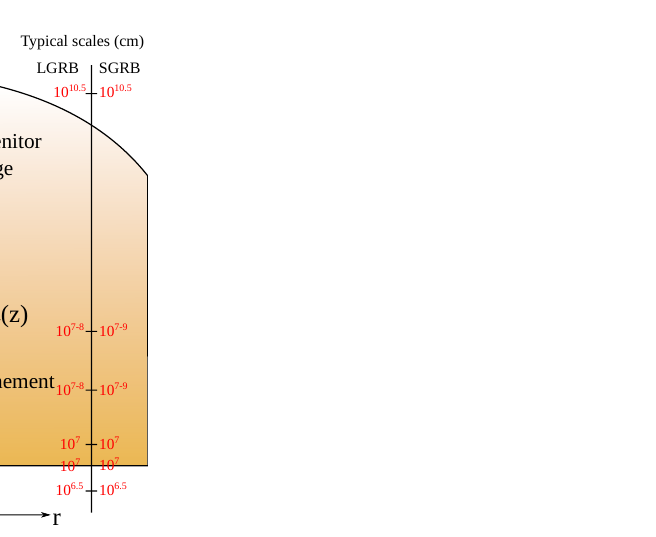
Figure 3. Sketch of the main elements in a basic hydrodynamical model of the jet propagation through the progenitor vestige. Adapted from